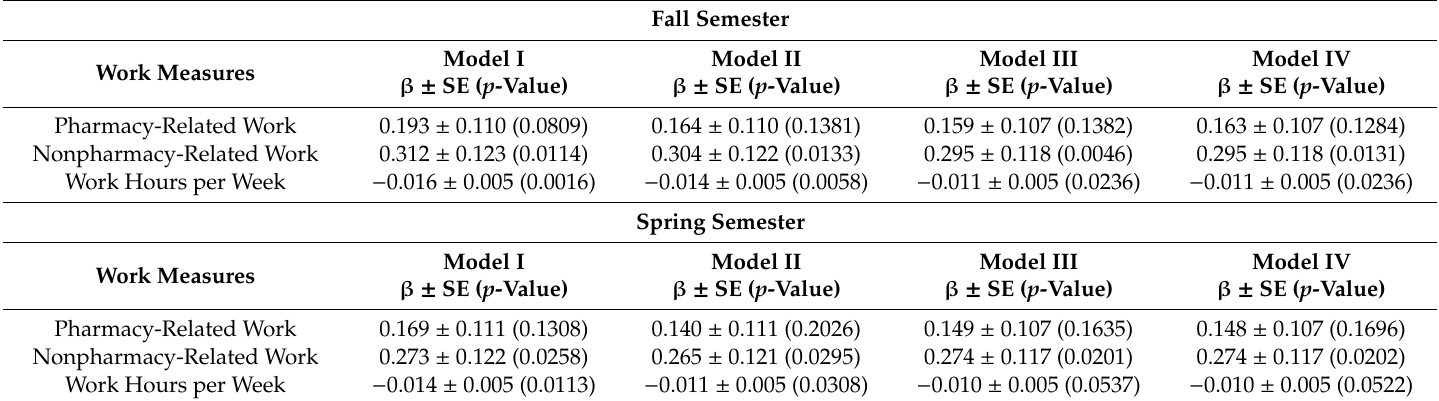
Table 3. Association of workload with academic performance (grade point